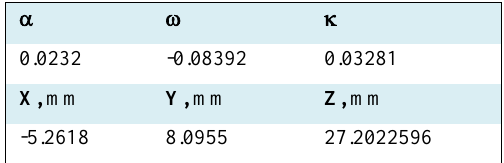
Table 4. The mean errors in UAV position and UAV angular orientation